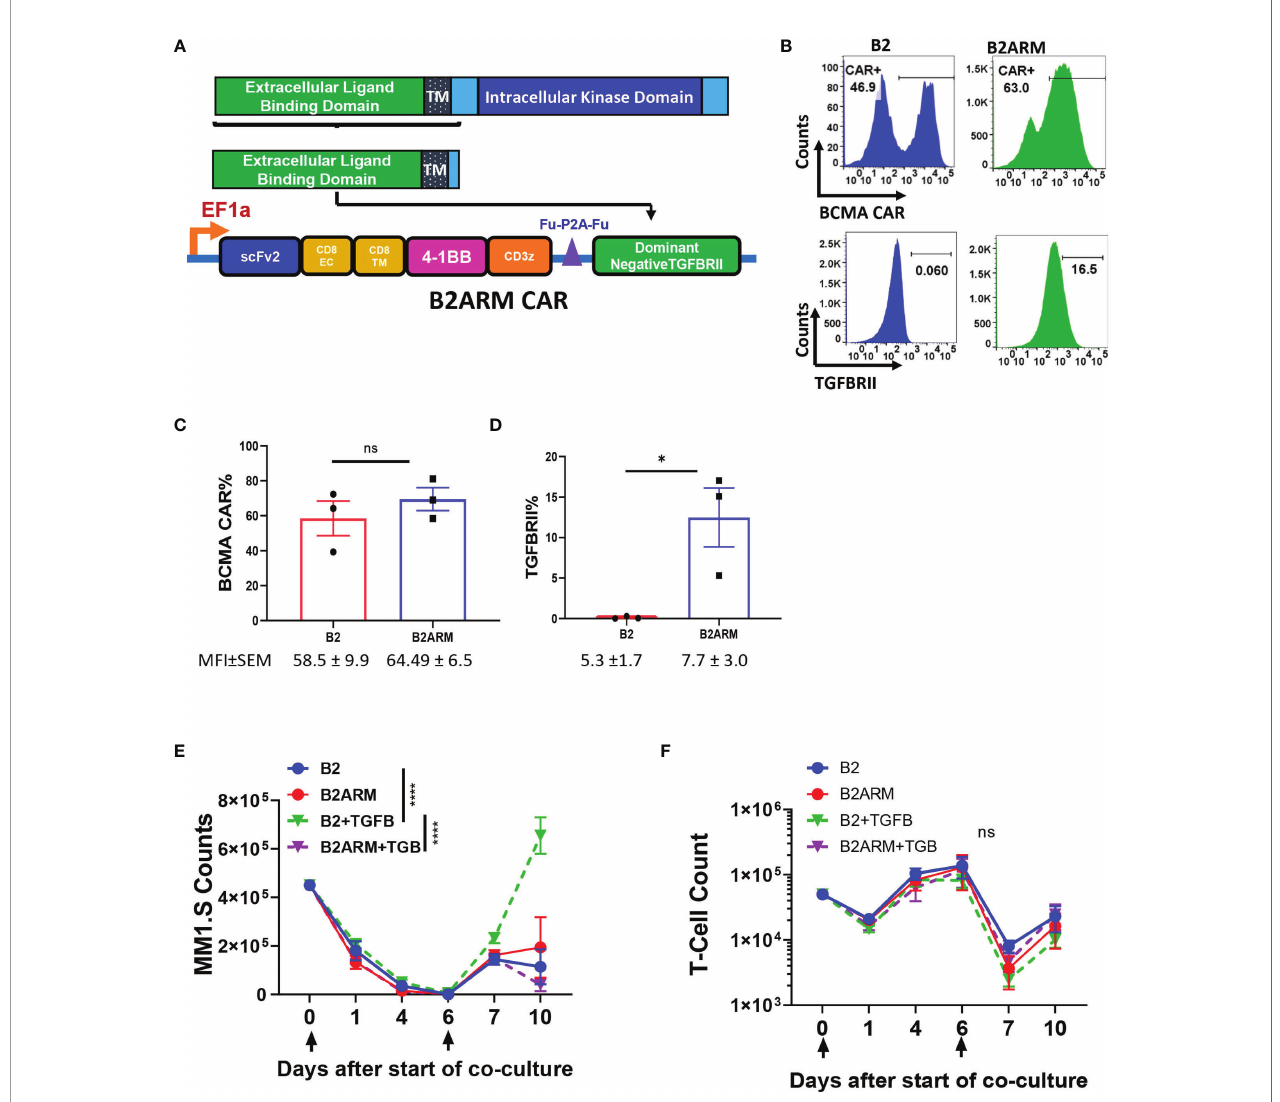
FIGURE 3 | The B2ARM T-cells with the truncated TGFBRII dominant negative receptor are resistant to the suppressive effects of TGF- b . (A) To create the armored B2ARM BCMA CAR, the sequence of the extracellular and transmembrane domains of TGFBRII, excluding the intracellular kinase domain, was cloned in frame downstream of the B2 CAR construct. (B) T-cells were transduced with lentiviral vectors containing either the B2 CAR construct at MOI 10, or the B2ARM construct at MOI 80, in order to compensate for the lower transduction ef fi ciency of the armored B2ARM CAR construct, which is larger. The cell surface expression of the BCMA CAR (upper panel) and TGFBRII (lower panel) was assessed by fl ow cytometry. One representative donor is shown. (C) Pooled results from transduction experiments with B2 and B2ARM constructs showing the expression of (C) the CAR and (D) the TGFBRII armor in T cells from three separate donors, mean ± SEM. *p<0.05, Student t-test, ns, non-signi fi cant. Mean ± SEM of mean fl uorescence intensity (MFI) values for each experimental group are shown below the fi gures. In the long term co-culture experiment, CAR T-cells were co-incubated with the target cells, MM.1S-GFP, at an ETT ratio of 0.1, and the culture was treated with 10ng/ml of TGF-beta or remained untreated. When less than 15% of target cells remained on day 6, the co-culture was extended for a second round by adding the co- culture cells from the previous round to fresh target cells. The absolute counts of (E) T-cells and (F) target cells at different time points during the long-term co- culture was assessed by quantifying the number of CD3+ and GFP+ cells via fl ow cytometry using absolute counting beads. Data represent mean ± SEM of separate long term experiments performed in T cells from three different donors. Statistical analysis was performed by two way ANOVA with Tukey ’ s multiple comparisons test,